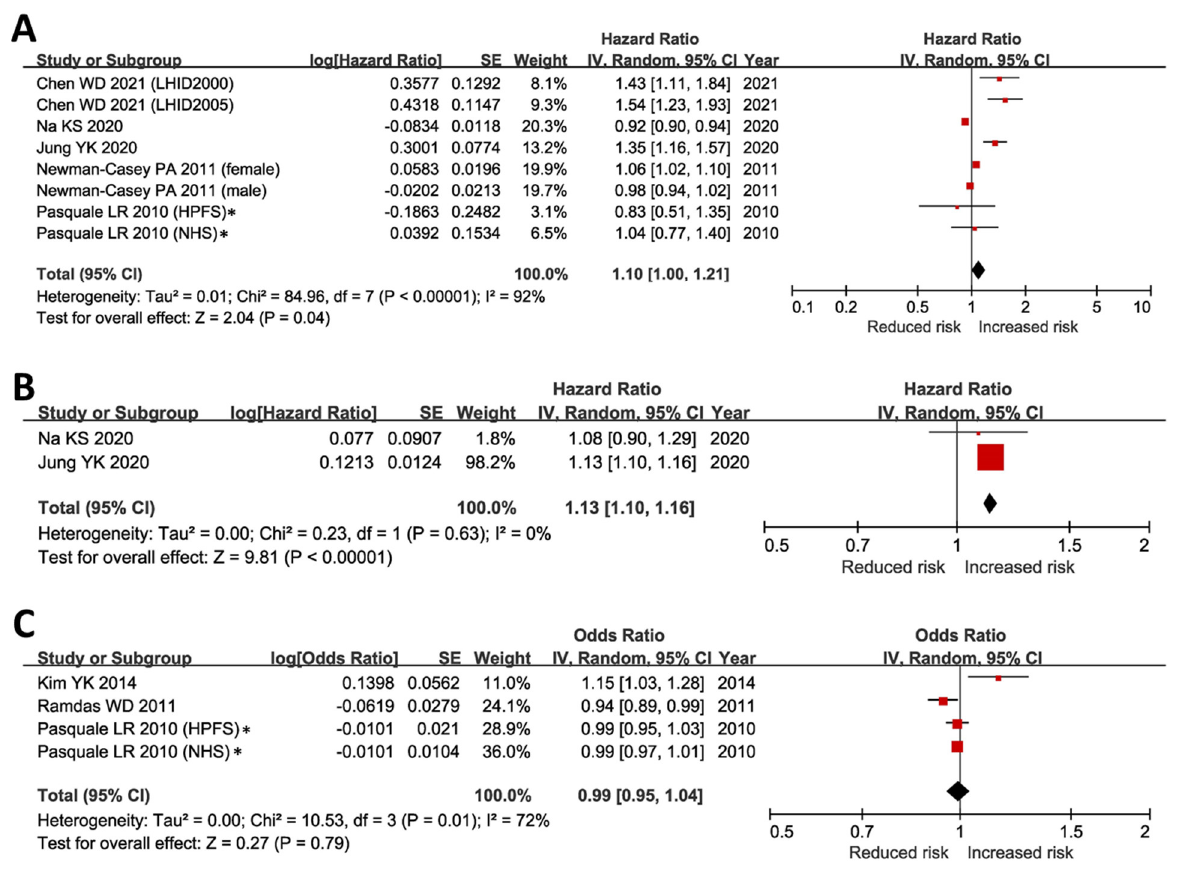
Figure 1. Associations of obesity, underweight, and BMI with incidence of open-angle glaucoma. ( A ) Incidence of POAG was significantly higher in obese subjects (BMI ≥30 kg/m 2 ) when compared to individuals with normal BMI ( p = 0.04). ( B ) Incidence of POAG was significantly higher in underweight individuals ( p < 0.001). ( C ) The association of BMI with the risk of POAG was negligible when BMI was analyzed as a continuous independent variable ( p = 0.79) [4,5,10,11,17,24]. BMI, body mass index; CI, confidence interval; IV, inverse variance; POAG, primary open-angle glaucoma; SE, standard error. * In Pasquale LR’s study, the incidence of POAG was <1% during the follow-up period [15]. Therefore, we included the reported relative risk in our meta-analyses of obesity and BMI outcomes, assuming that the risk ratio, odds ratio, and hazard ratio were comparable under a very low incidence of POAG [26,27]. In sensitivity analysis, the results remained unchanged after excluding the risk ratios reported in Pasquale LR’s report [15].